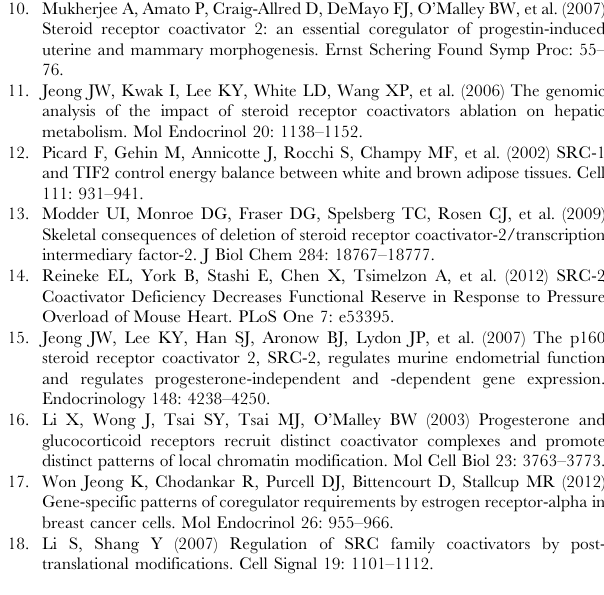
Table S7 Upregulated overlapping differentially ex- pressed genes induced by SRC-2 shRNA and cAMP.